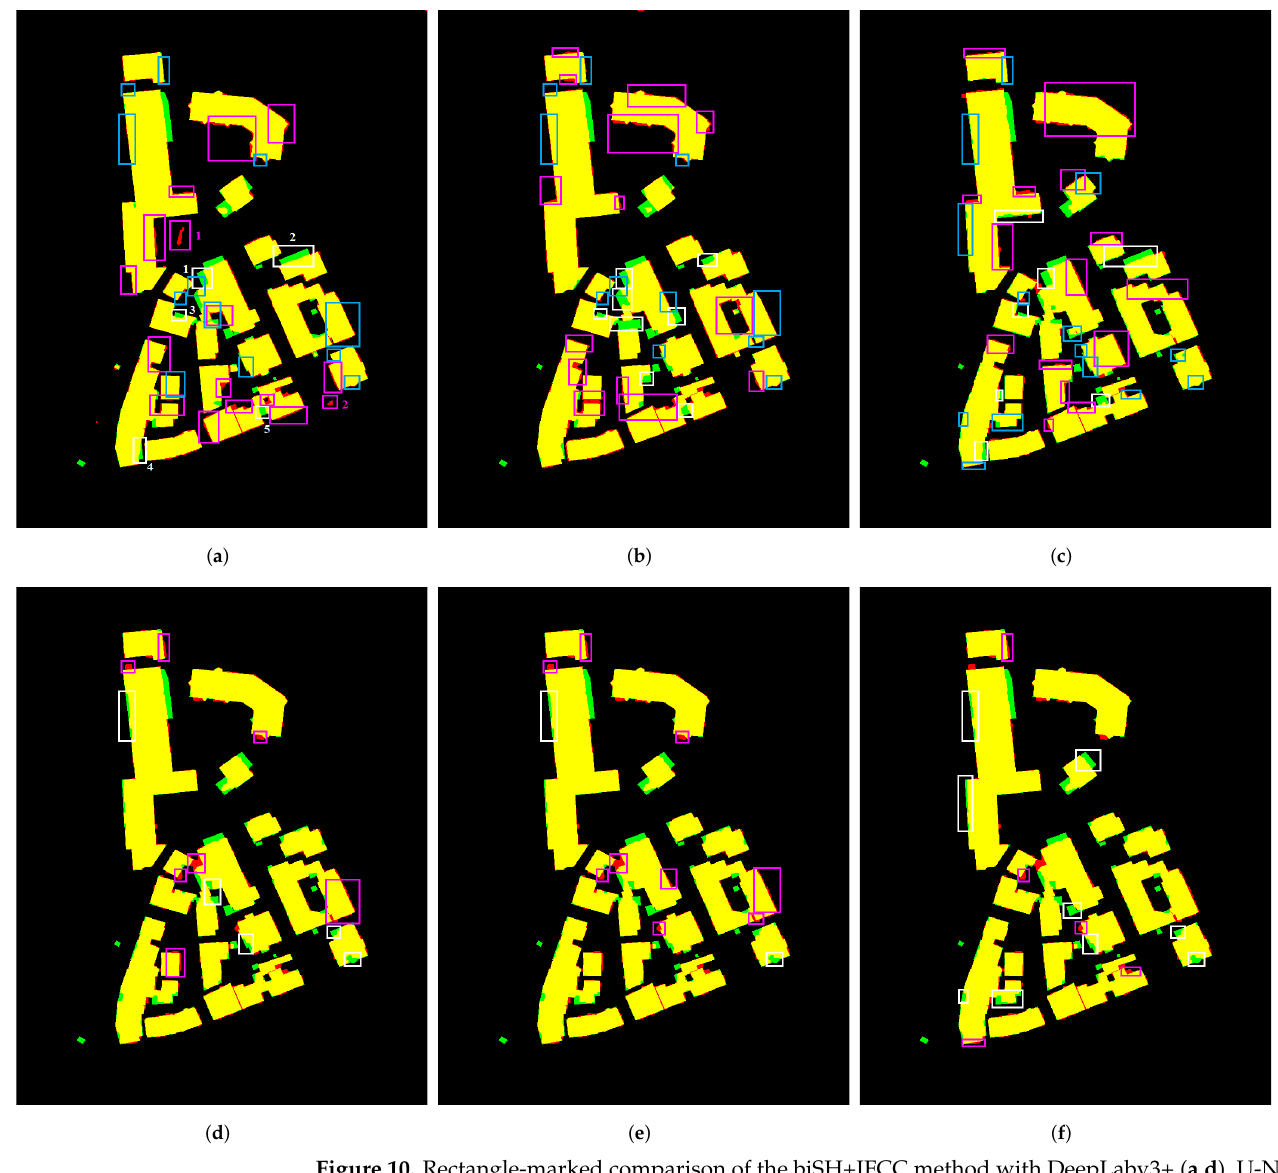
Figure 10. Rectangle-marked comparison of the biSH+IFCC method with DeepLabv3+ ( a , d ), U-Net ( b , e ) and the HOA method ( c , f ) on the first test area. In ( a – c ), the rectangles are drawn on the results of the compared methods, while in ( d – f ), the rectangles are drawn on the result of the biSH+IFCC